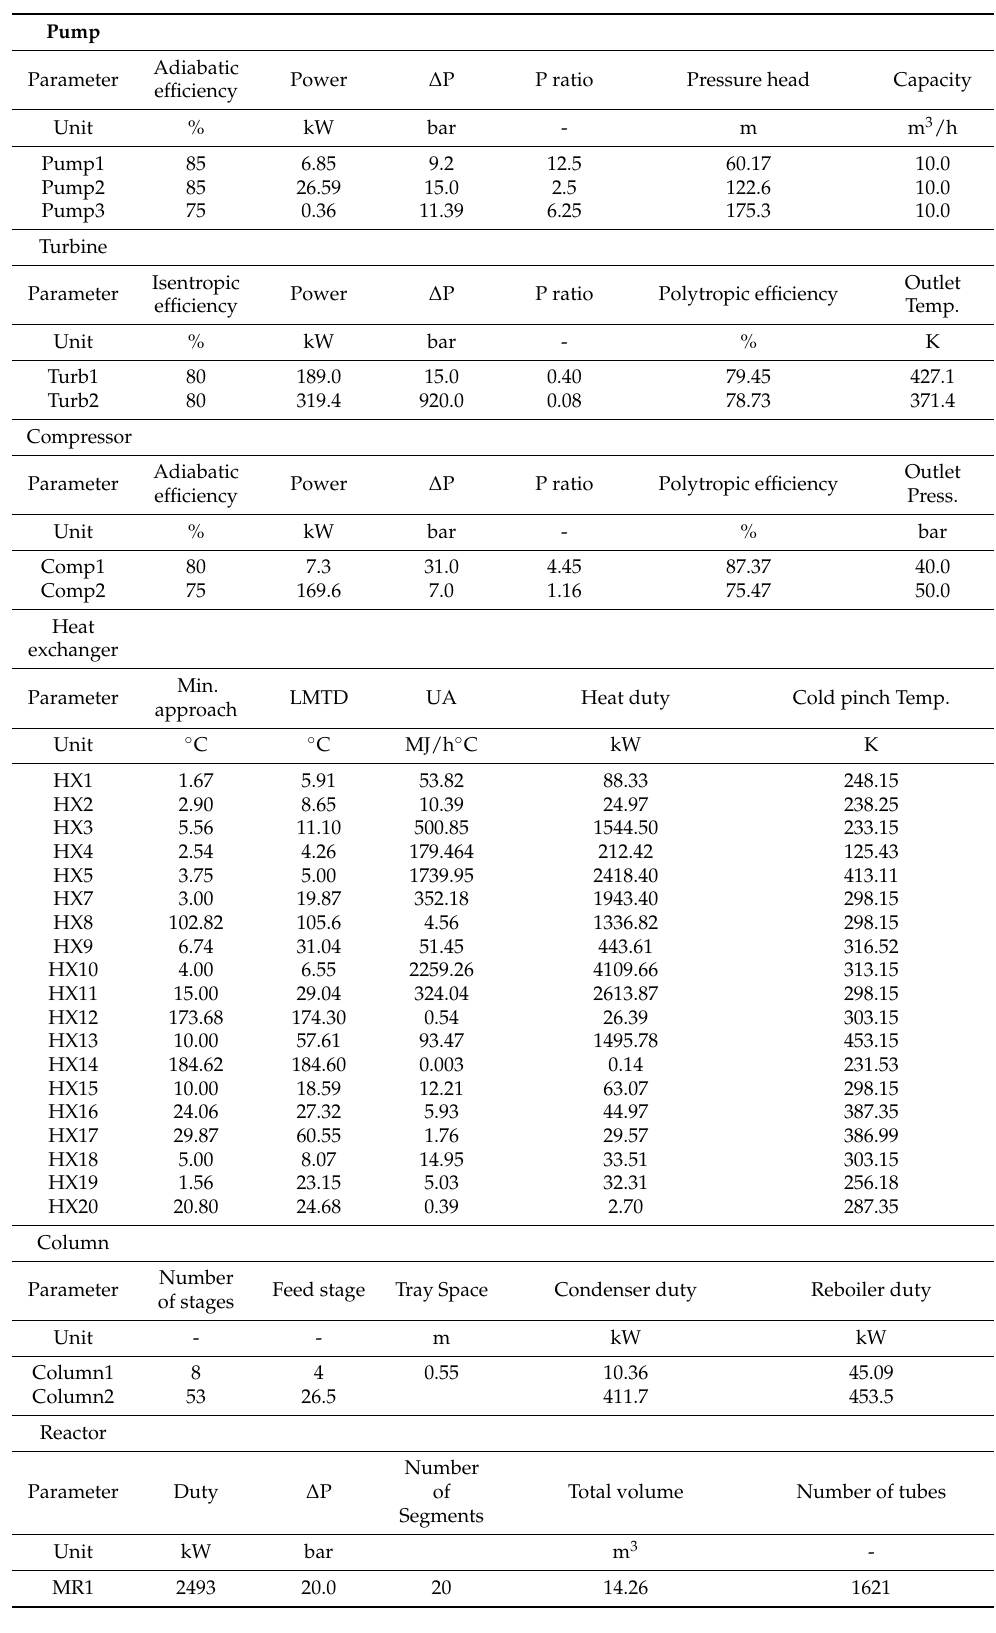
Table 2. Equipment major